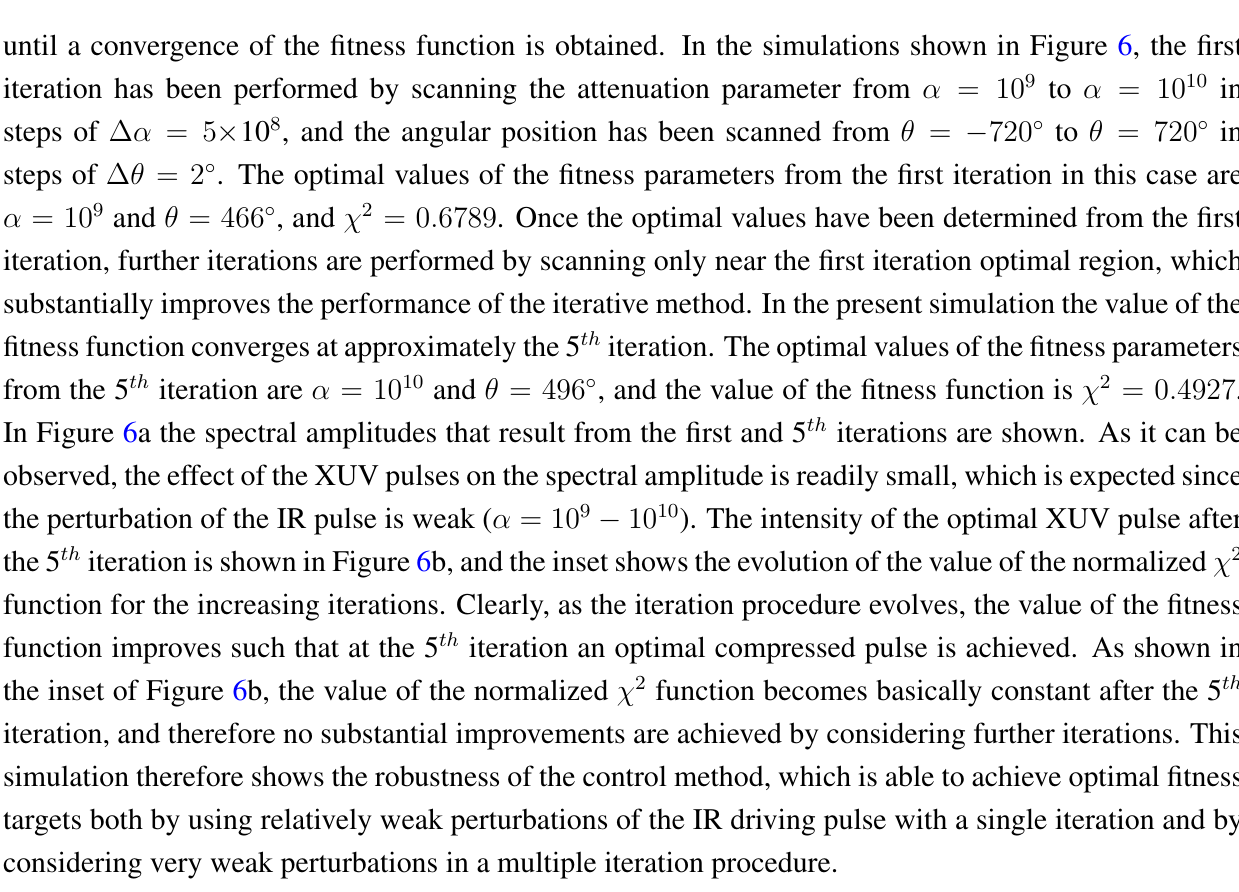
Figure 5. (color online) Time-frequency analysis of the original ( a ) and optimized ( b ) spectra, for the case shown in Figure